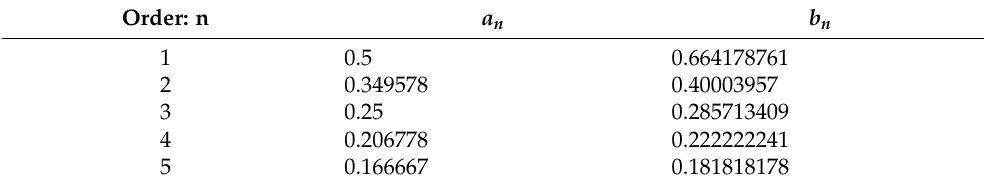
Table 1. Calculation of the length